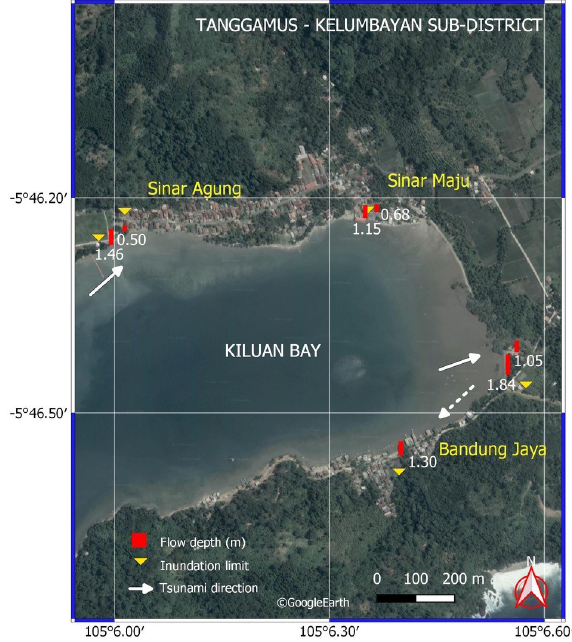
Figure 12. Tsunami flow depths distribution in Teluk Kiluan, Lam- pung. An arrow represents the tsunami wave direction reflected from the close end of the bay. (The map was adapted from Google